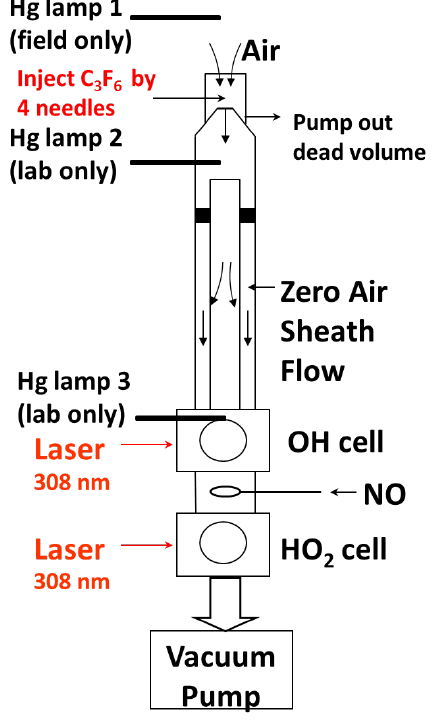
Figure 1. Schematic diagram of the detection system cross section. Gaseous C 3 F 6 was Fig. 1. Schematic diagram of the detection system cross injected simultaneously through four 0.25 mm needles pointed toward the center, which were located about 4 cm above the inlet. Hg lamp 1 was deployed in the field to ensure that the C 3 F 6 or propane removed most of the externally generated OH. Hg lamp 2 and 3 were installed only in the lab to determine how much OH is removed internally with the external C 3 F 6 addition. Hg lamp 2 was added just under the inlet cone and was shrouded so that it shone only across the flow and not up or down. Hg lamp 3 was inserted in the ring just above the OH detection cell and shone light into the sheath flow and the detection axis.